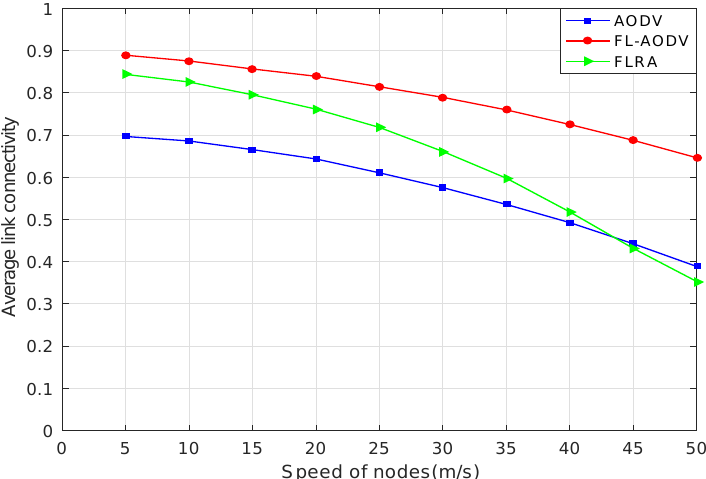
Figure 13. Comparison of average link connectivity at different